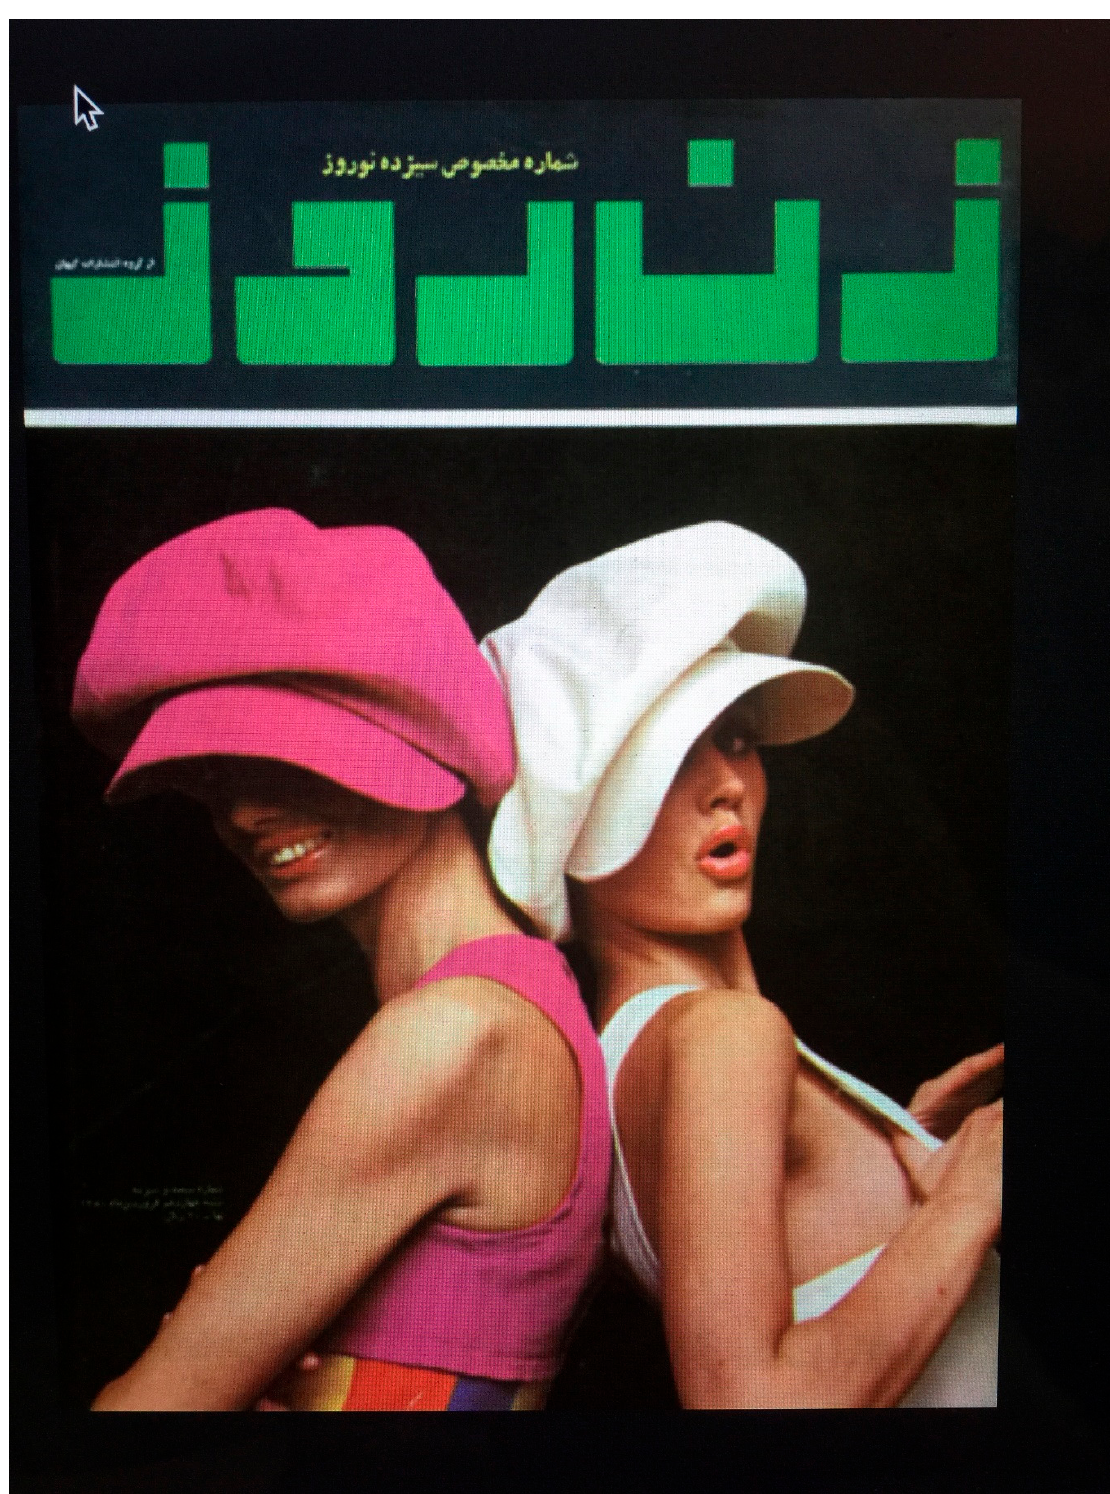
Figure 5. Cover of Zan e Rooz (Today’s Woman) Magazine 1970s. http://www.parstimes.com/fashion/pre_revolution/.